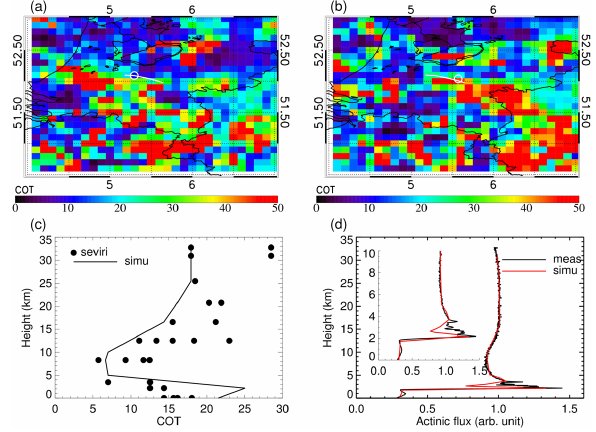
Figure 10. Same as Fig. 9 but for 15 June 2006.